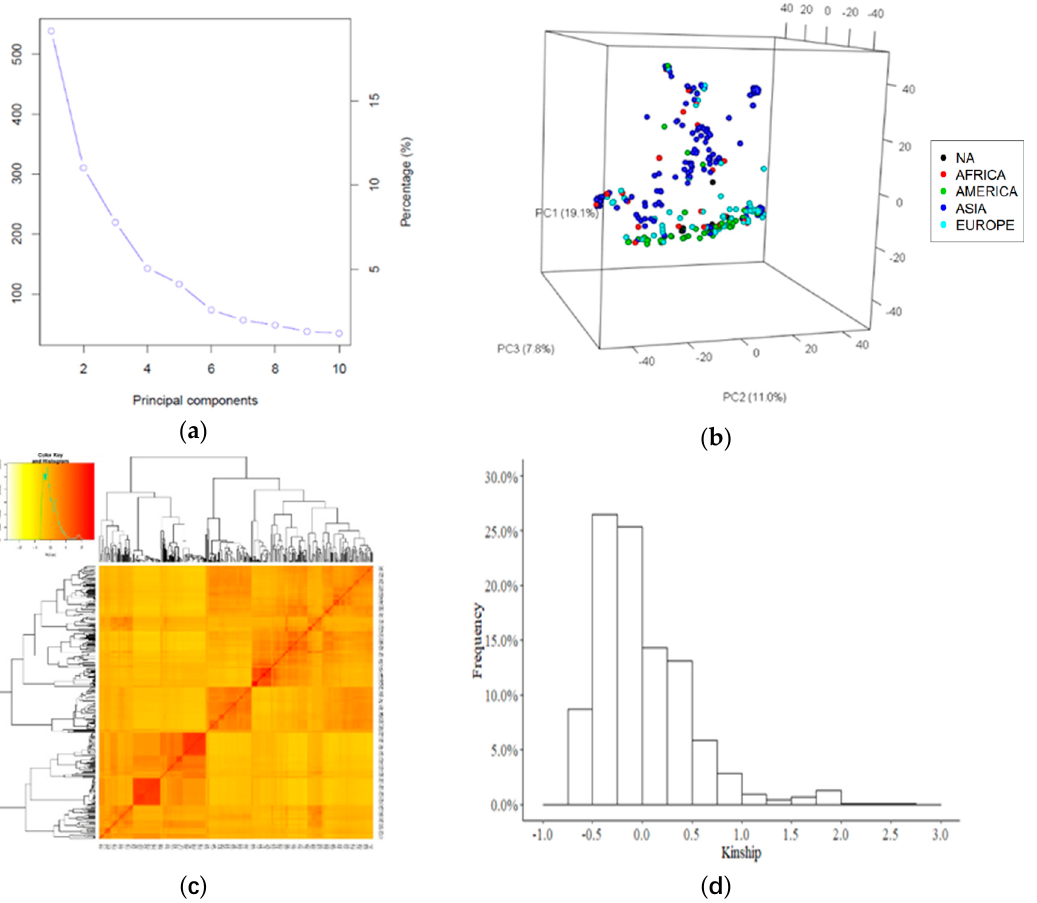
Figure 2. Population structure of the association mapping population. (a) The scree plot of first 10 principle components (PCs). (b) The three-dimensional principle component analysis (PCA) plot represents the distribution of the lentil accessions on the first three PCs. The colors represent various continents: red-Africa, green-America, blue-Asia, light blue-Europe, and black-data not available. (c) Cluster heatmap of the Kinship matrix. (d) Histogram of kinship coefficients .